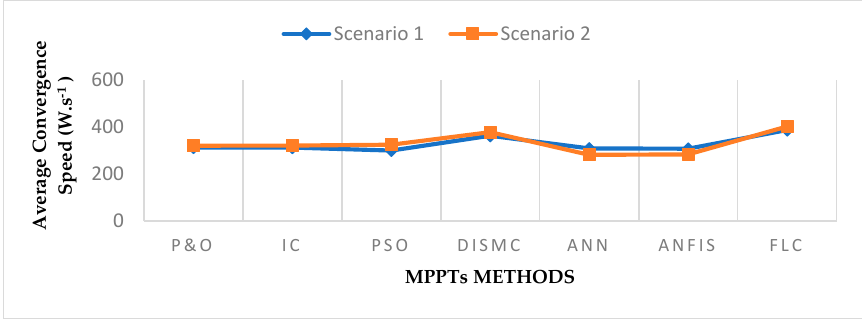
Figure 20. Average convergence speed of MPPT algorithms: Test 2.